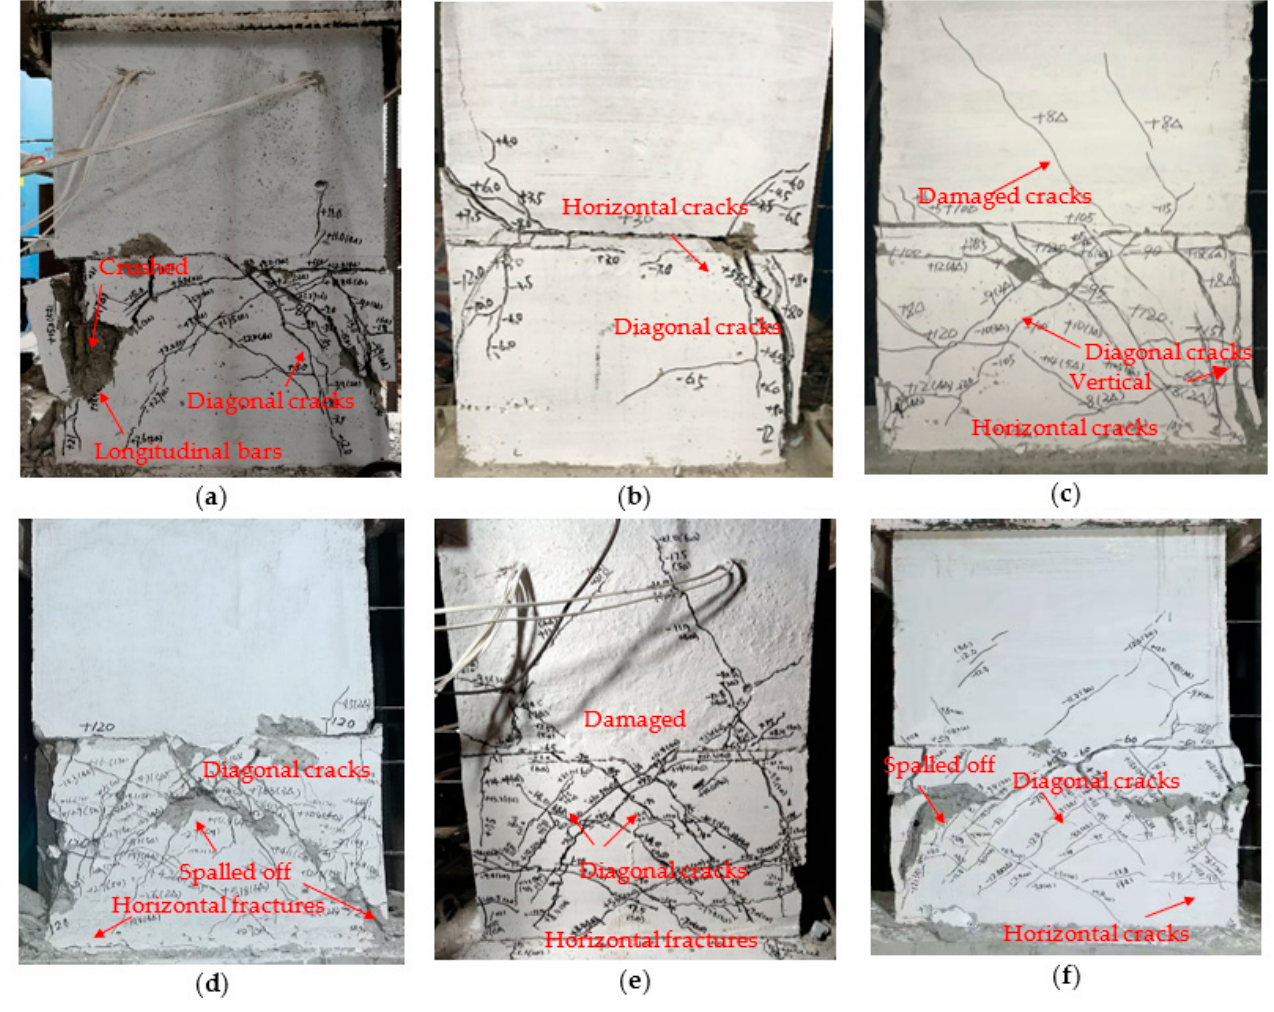
Figure 7. Failure mode s of PW1-PW6: ( a ) PW1; ( b ) PW2; ( c ) PW3; ( d ) PW4; ( e ) PW5; and ( f ) PW6.